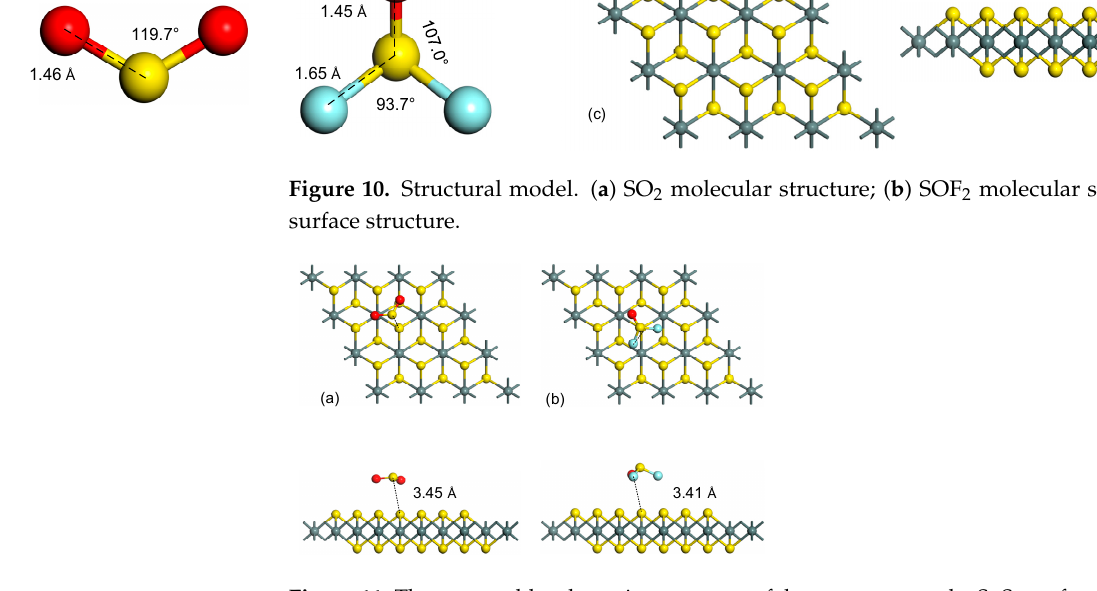
Figure 11. The most stable adsorption structure of the two gases on the SnS 2 surface structure. ( a ) SO 2 adsorption system; ( b ) SOF 2 adsorption system.